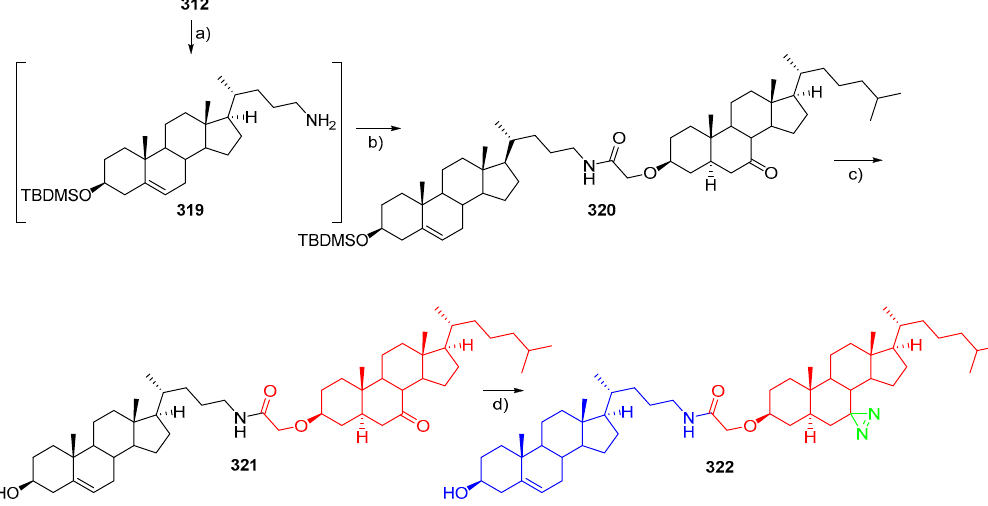
Scheme 78. Synthesis of cholesterol-based crosslinker with photoaffinity label. Reagents and conditions: a ) PPh 3 , THF/H 2 O, reflux, 3 h; b ) 318, DCC, DMAP, CH 2 Cl 2 , 25 °C, 1.5 h; c ) HF.pyridine,